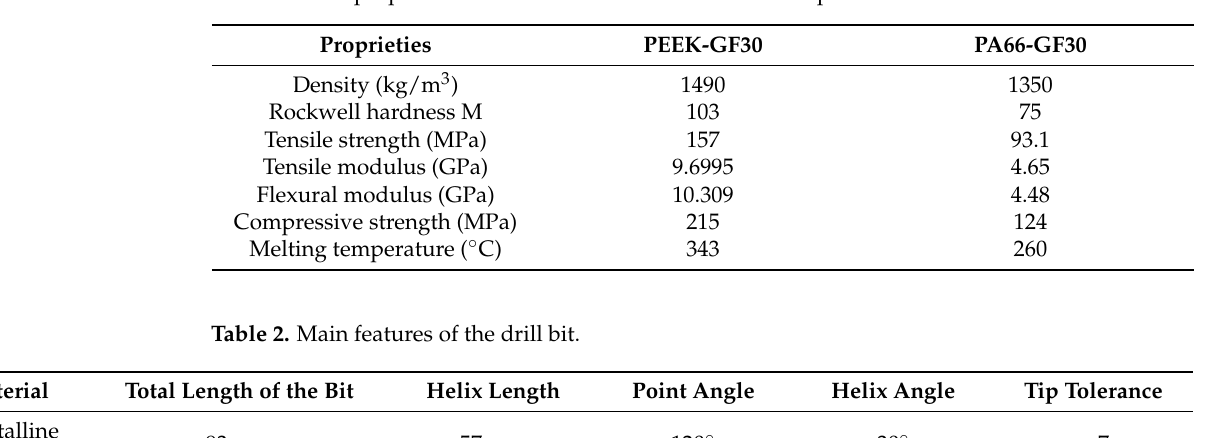
Table 1. Main proprieties of PEEK-GF30 and PA66-GF30 composites.